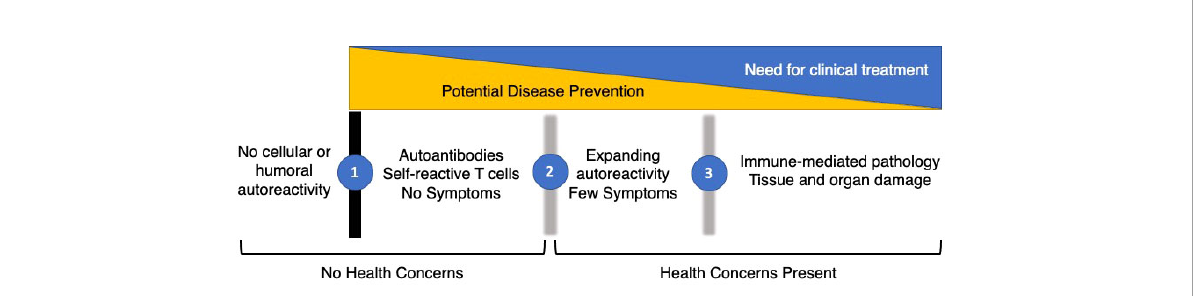
FIGURE 1 Phases of Autoimmunity. The majority of the healthy population has no evidence of cellular or humoral autoimmunity. However, a substantial fraction develops autoantibodies or self-reactive T cells while remaining asymptomatic (1). These individuals typically do not seek medical care unless it is to explain serological fi ndings. After a period of years, characterized by expanding serological autoimmunity and up-regulation of in fl ammatory cytokines and chemokines, early symptoms develop in a sub-set of people with asymptomatic autoimmunity (2). With the accumulation of suf fi cient clinical signs and symptoms, patients are classi fi ed with de fi nite autoimmune conditions (3). If possible, the prevention of autoimmunity will take place in the earliest phases before there are signi fi cant health concerns present. Later clinical treatments will address organ damage and dysfunction but are less likely to halt disease progression over